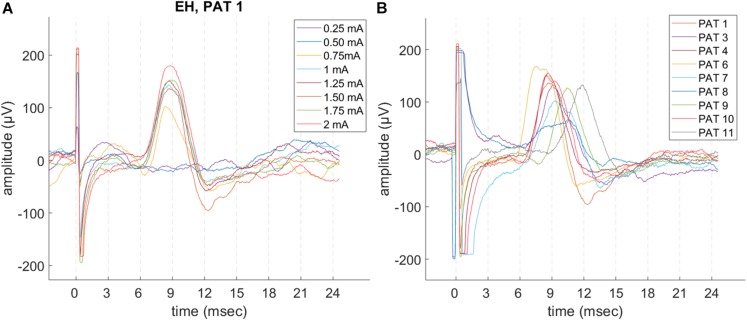
Example of LMEP single epochs, in patients with a good signal-to-noise ratio (SNR) and sampling rate at 32 kHz. (A) Intra-patient reproducibility (PAT 1), in different trains at increasing current output. (B) LMEPs recorded across different patients, at their respective normal current output (1–1.75 mA). Variation of amplitudes and latencies can be appreciated. Latencies are comprised in a 5.4–8.7 ms range (mean: 6.89 ms). PAT 2 is not shown due to a sampling rate of 2048 Hz that hampers a meaningful overlay. PAT 5 is not shown due to low SNR.